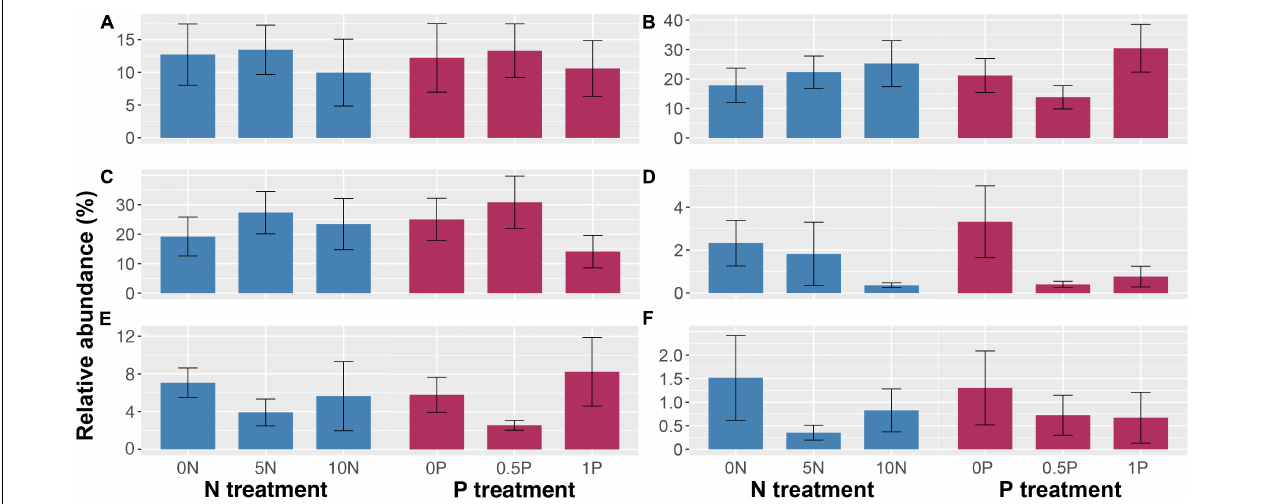
FIGURE 5 | Relative abundance (mean ± SE) of ericoid mycorrhizal fungi (A) , ectomycorrhizal fungi (B) , arbuscular mycorrhizal fungi (C) , lignocellulose-degrading fungi (D) , saprotrophic fungi (not including lignocellulose-degrading fungi) (E) , and Sphagnum -associated fungi (F) in response to short-term N and/or P additions. Treatment abbreviations as described in “Materials and Methods” section.